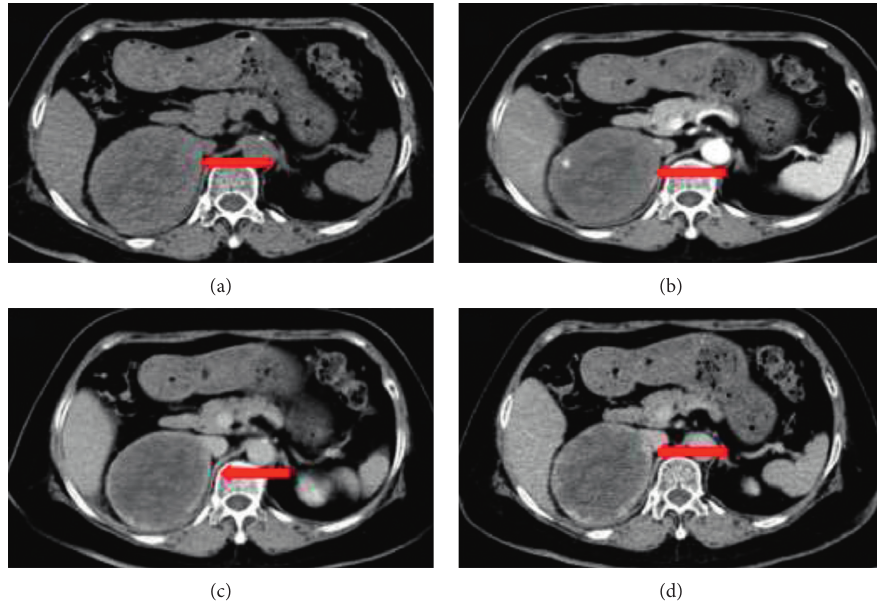
Figure 3: Right adrenal cavernous hemangioma with a tumor size of 10cm. CT showing mild heterogeneous enhancement of the tumor during the arterial phase and progressive enhancement in the venous phase and the delayed phase (red arrow). (a) Enhanced CT. (b) Arterial phase of CT. (c) Venous phase of CT. (d) Delayed phase of CT.